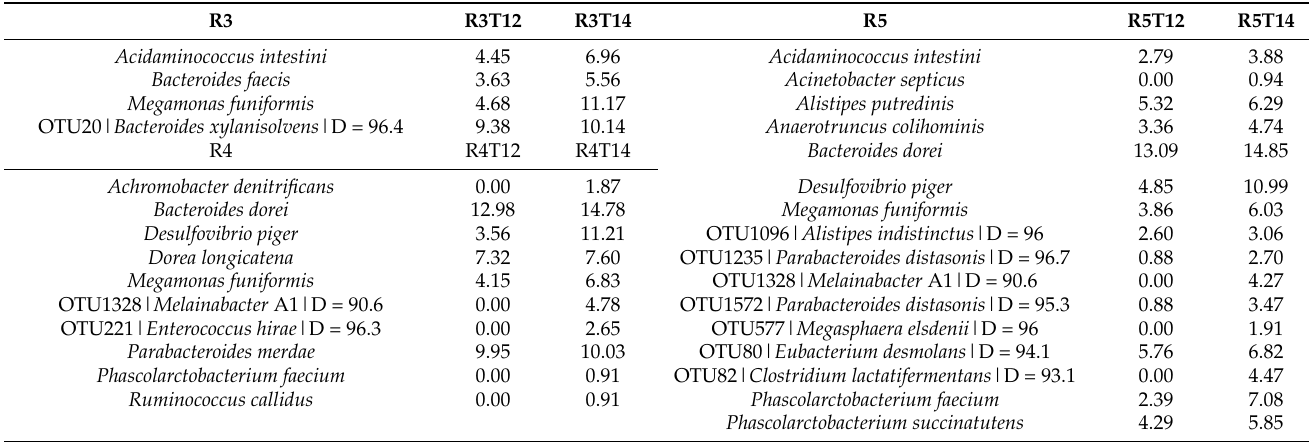
R3T14 the end of the treatment period. Values represent relative abundance %. transversal colon, ( R5 ) descending colon, before (T12) and after the treatment period (T14) with the biocompound.